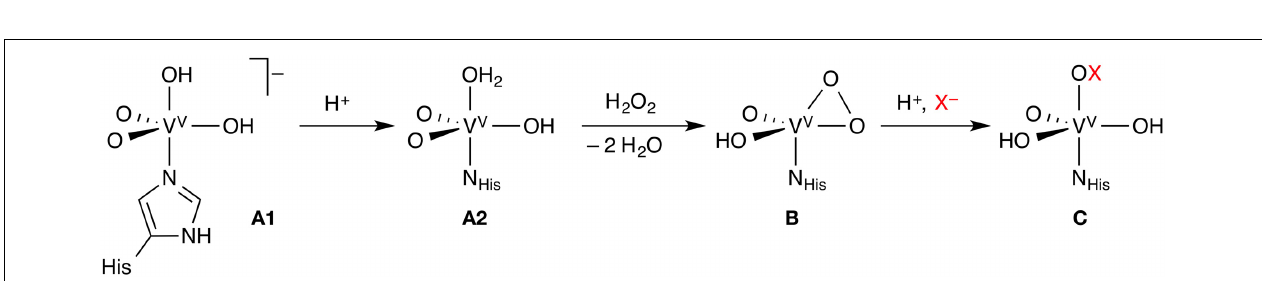
FIGURE 1 | Key steps of the mechanism of haem-dependent haloperoxidases. The Fe III hydroperoxido complex A (Compound 0) is oxidized to the Fe(IV) oxido species B (Compound I), which in turn oxidizes X − to XO − . O p and O d in A designate the proximal and distal oxygen atoms, respectively.